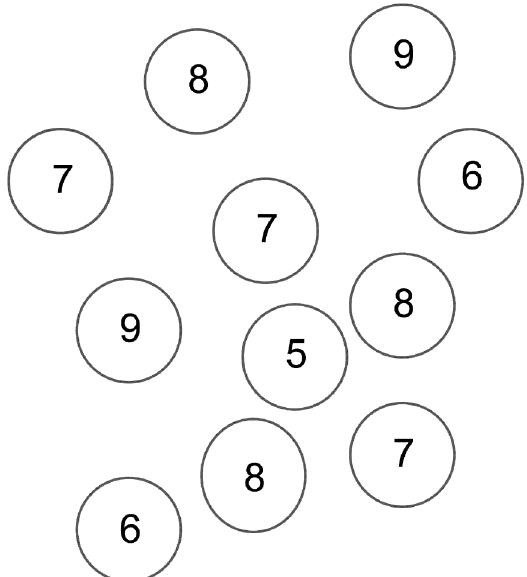
Figure 1. One of the twenty unique sums created. Each sum consisted of 11 single- digit numbers between one and nine. The numbers were categorized as low (1–4) or high (5–9) in order to generate a range of sums in a principled manner. A set of five sums was randomly allocated to each of the four experimental